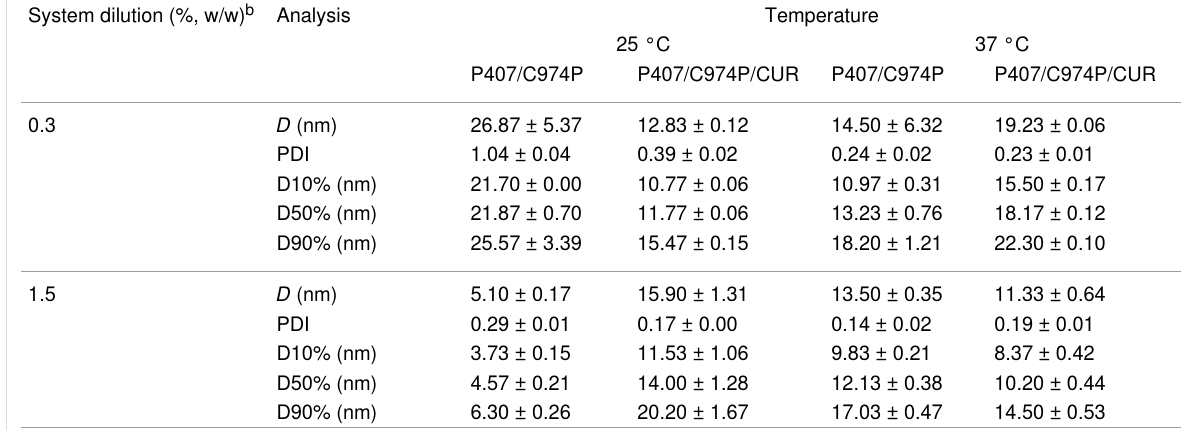
Table 2: Micelle size ( D ), polydispersion index (PDI) and micelle size distribution (D10%, D50% and D90%) of the nanostructured systems with and without CUR, evaluated at 25 °C and 37 °C a . System dilution (%, w/w) b